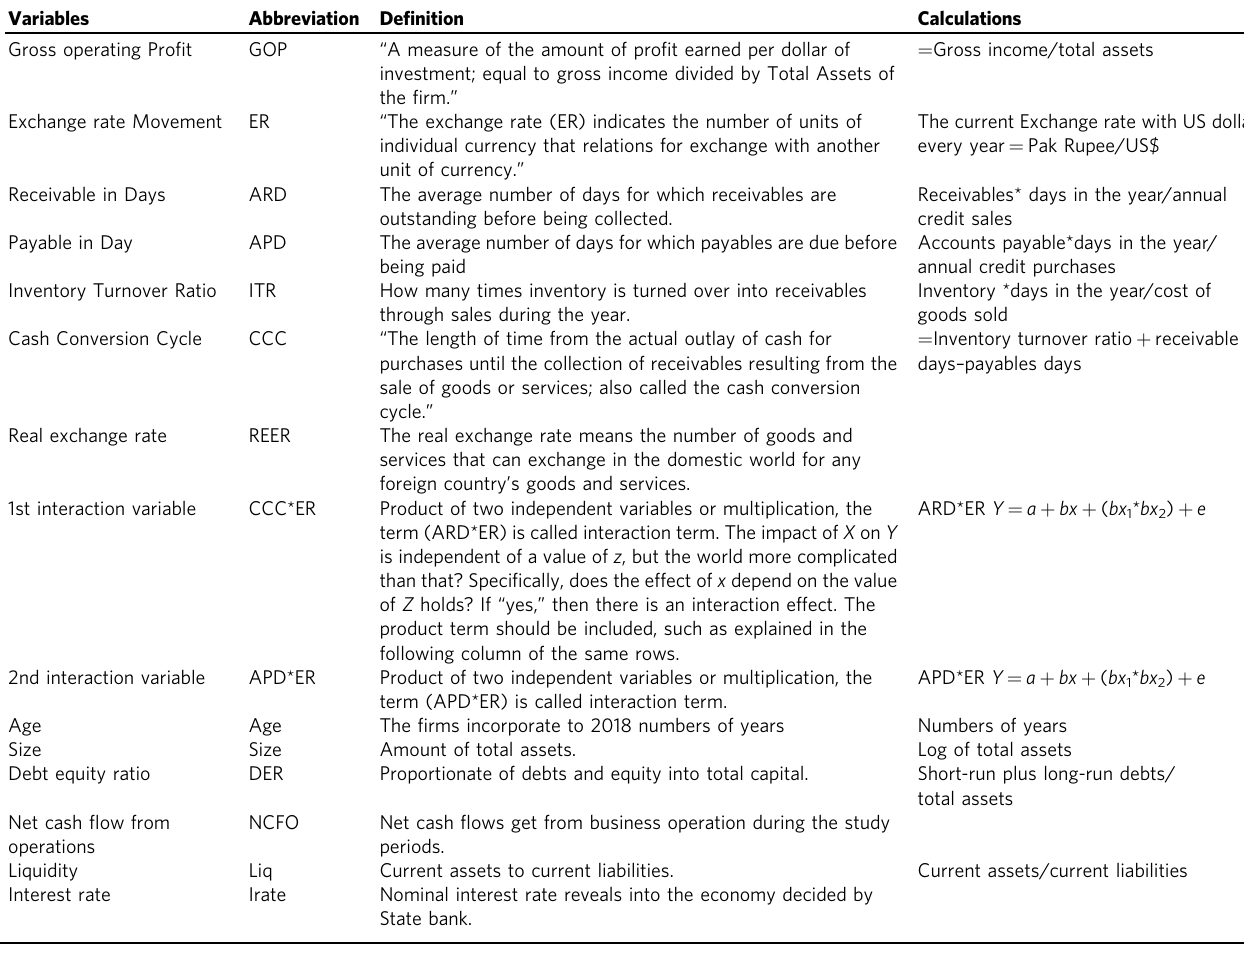
Table 1 De fi nition of the variables.